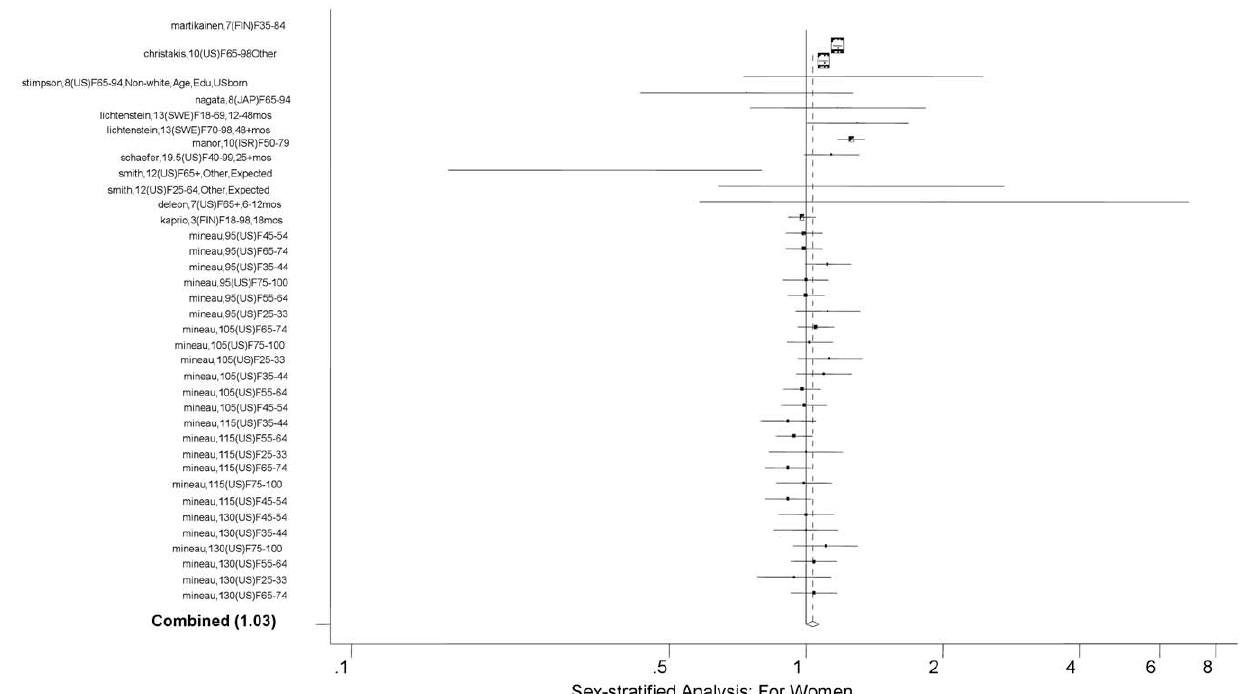
Figure 5. Forest Plot for Women.